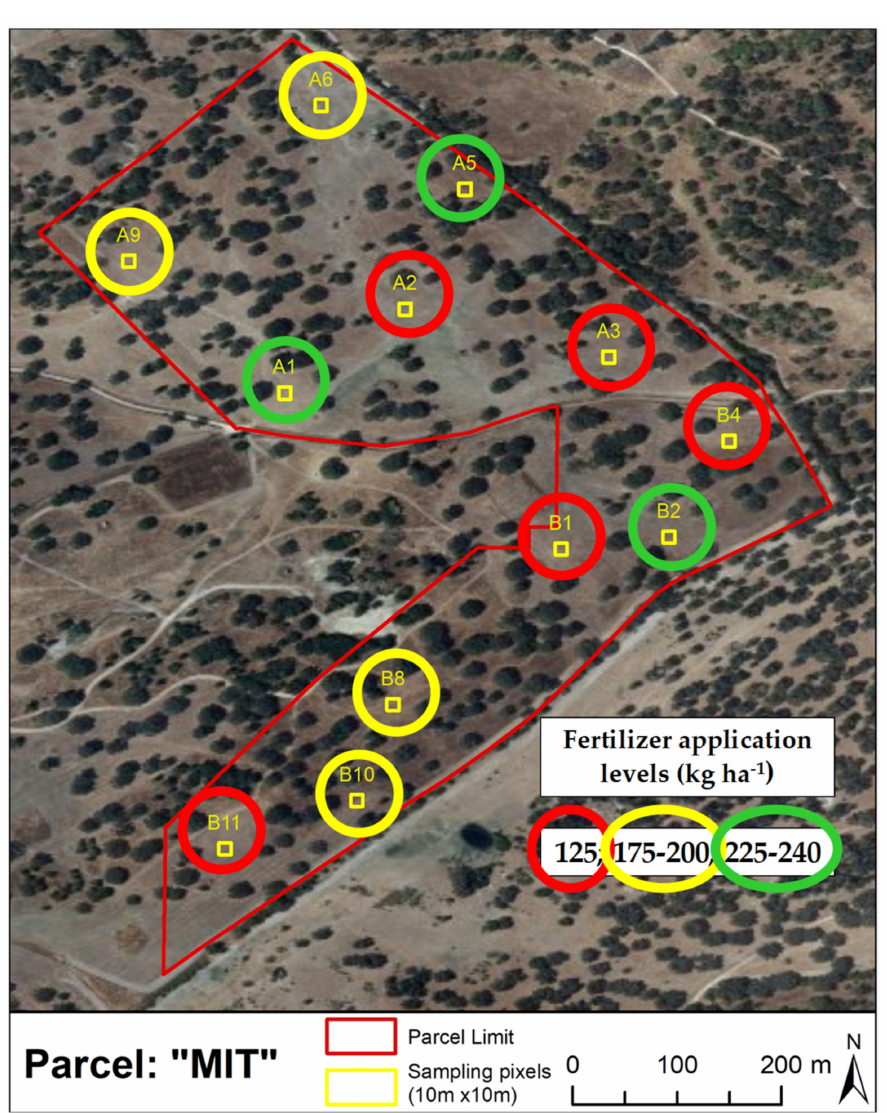
Figure 11. Impact of differential fertilizer application levels on sampling areas of the experimental